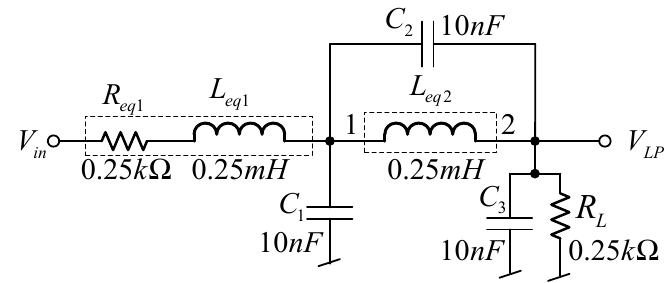
Figure 25. The 4th elliptic LP ladder filter.